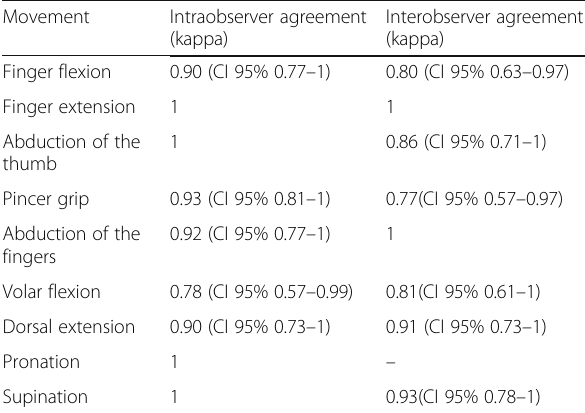
Table 2 Intraobserver and interobserver agreement for each evaluated movement Movement